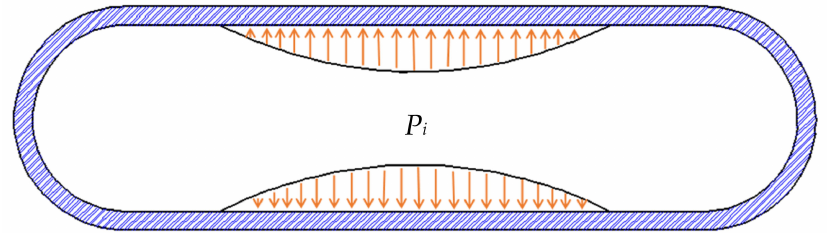
Figure 1. Geometric model of a metal cylindrical shell subjected to an internal explosive